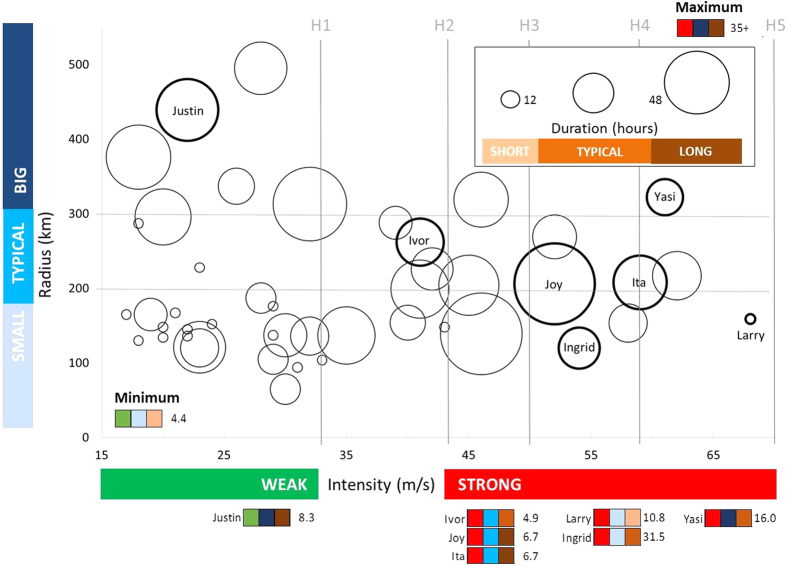
Relative intensity, circulation size, and duration of TCs near the GBR, 1985–2015.Grey lines show TC intensity rankings on the Saffir-Simpson scale. Intensity is shown on the y-axis as maximum wind speed (m s−1), and size on the x axis by the mean radius to gale force winds from the TC eye (km). The size of each circle shows the duration of gale force or higher winds (hours) within the GBR. The intensity, size and duration data for each TC in the diagram can be seen in Table 2.